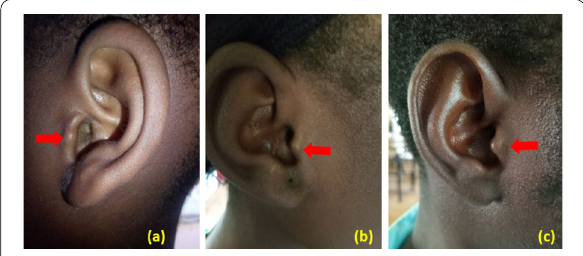
Fig. 6 Photographs of shapes of ear tragus: long ( a ), round ( b ), knob